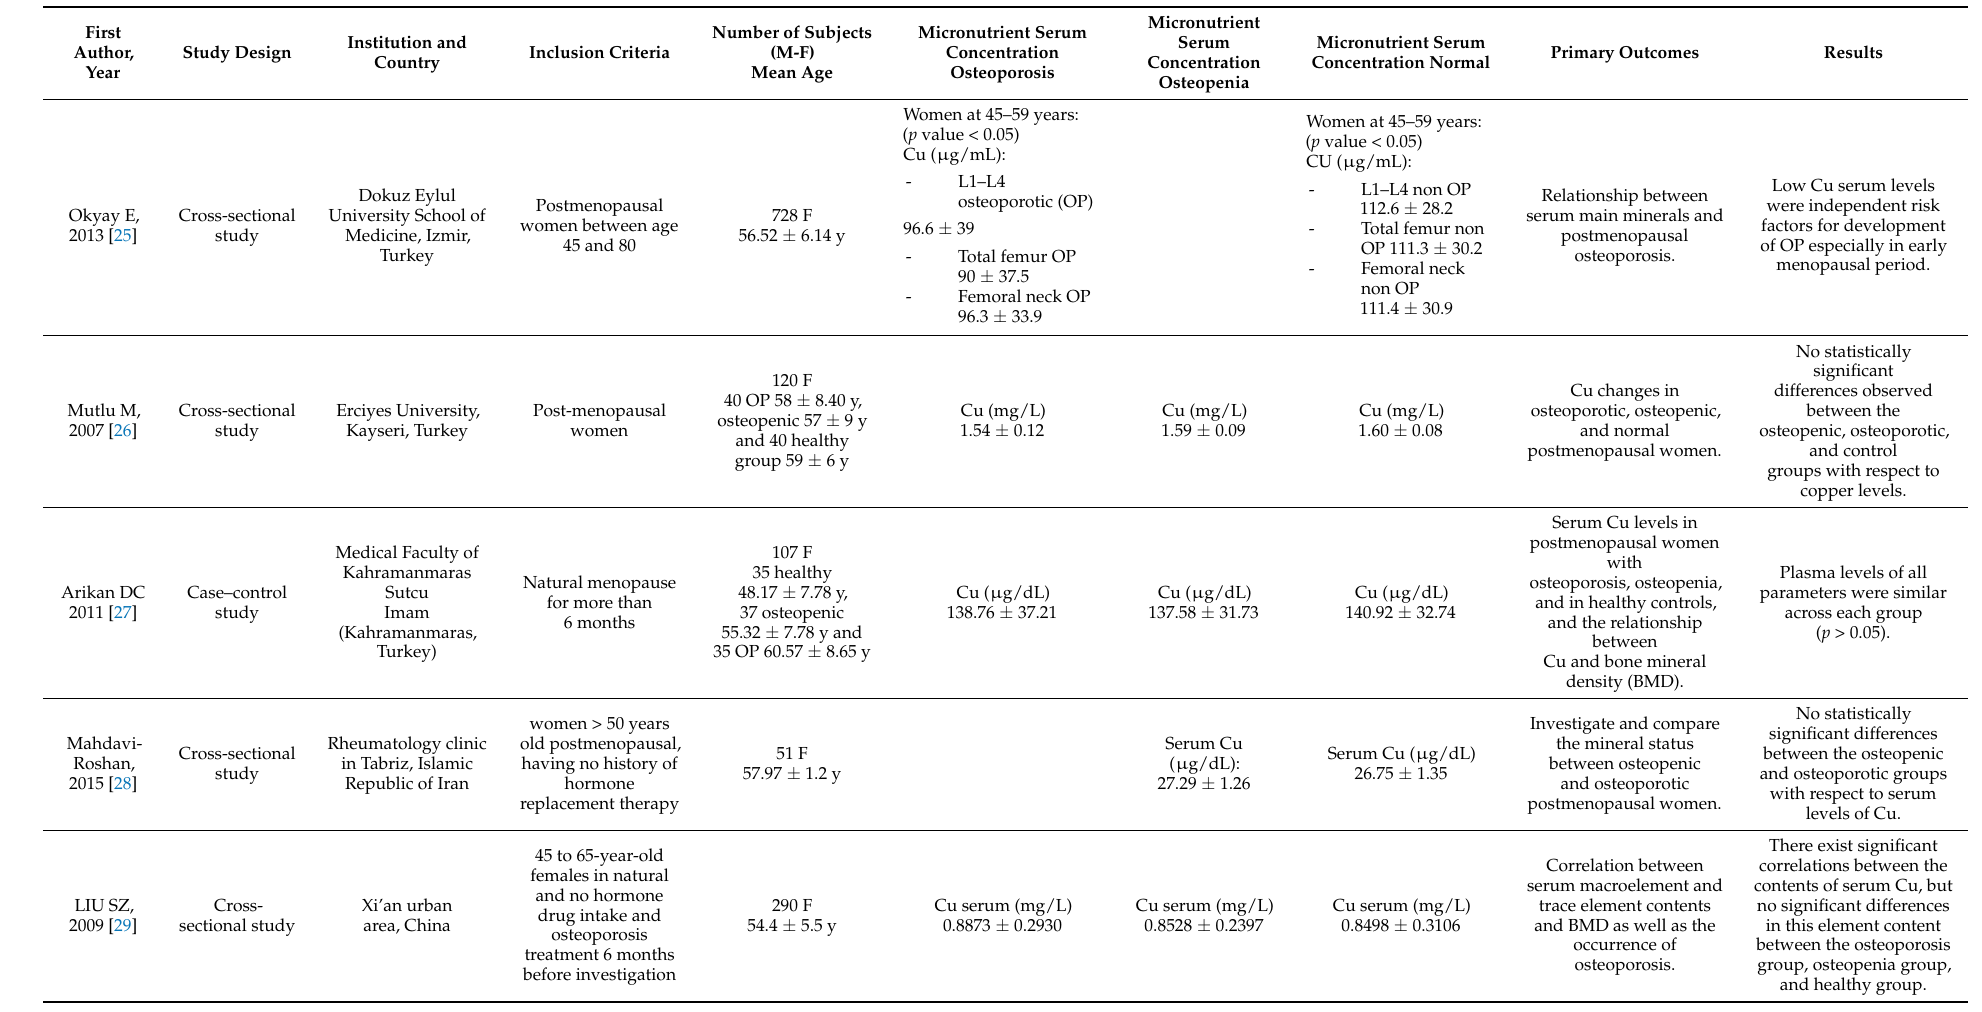
Table 1. Studies that considered blood copper